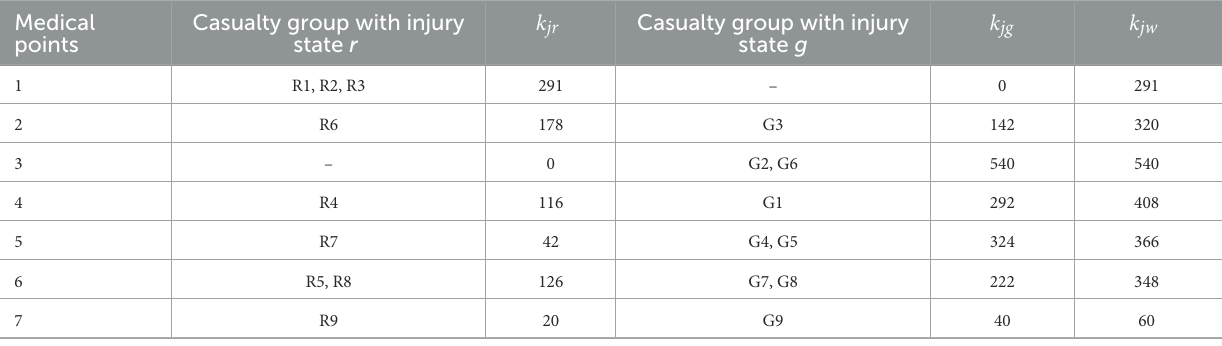
TABLE 2 Treatment information at medical points.